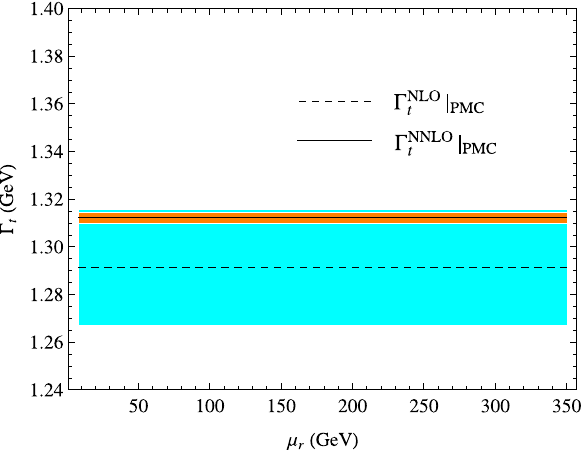
Fig. 2 Thetop-quarkdecaywidths (cid:5) t versustherenormalizationscale μ r using PMC scale setting, where the dashed and solid lines stand for the PMC predictions (cid:5) NLO t | PMC at NLO and (cid:5) NNLO t | PMC at NNLO, respectively. Two error bands stand for the estimation of the unknown higher-order QCD terms by using the Pad ´ e approximation